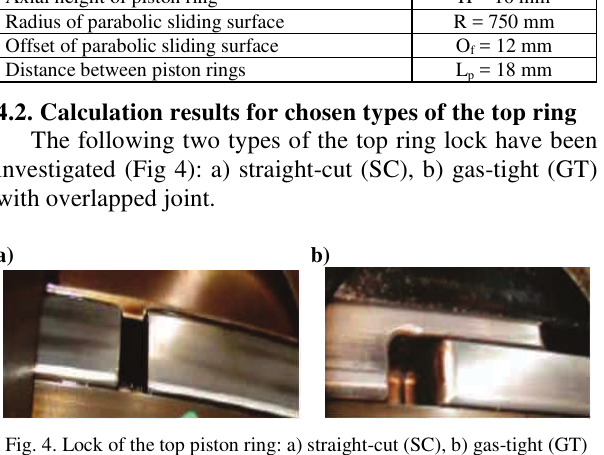
Table 2. Basic geometric parameters of piston rings: 1, 2, 3, 4 Axial height of piston ring